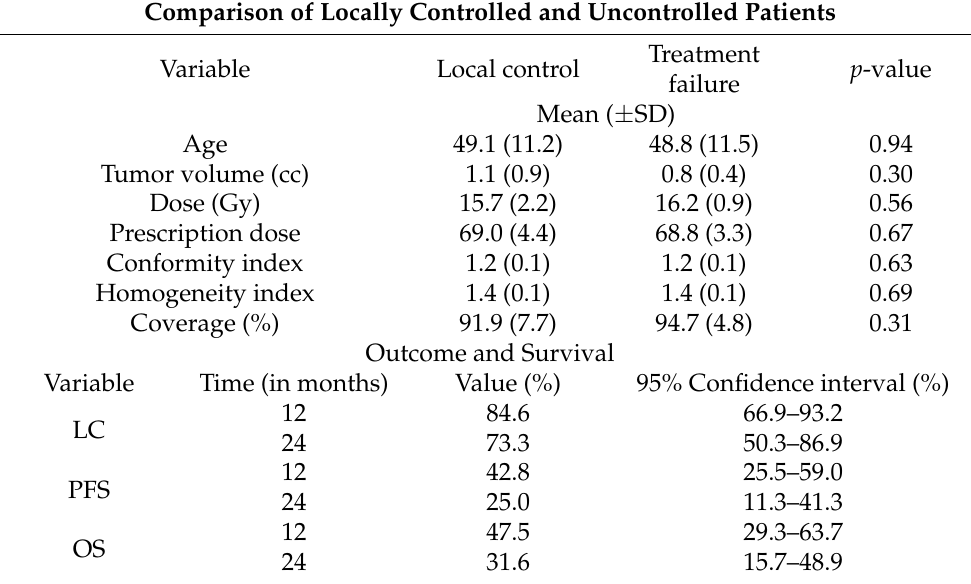
Table 2. Comparison between LC cases and local treatment failures with outcome and survival rates.